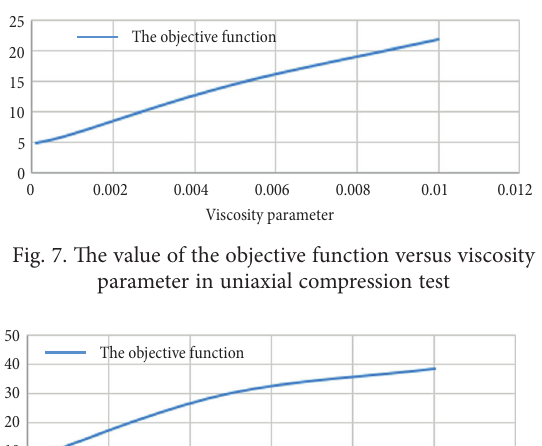
Fig. 4. The values of the objective function versus different eccentricities in biaxial compression test